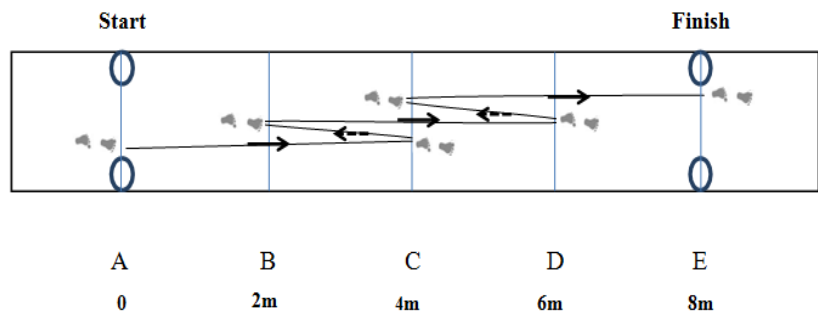
Figure 1. Specific fencing change of direction test (4/2/4/2/4-m).